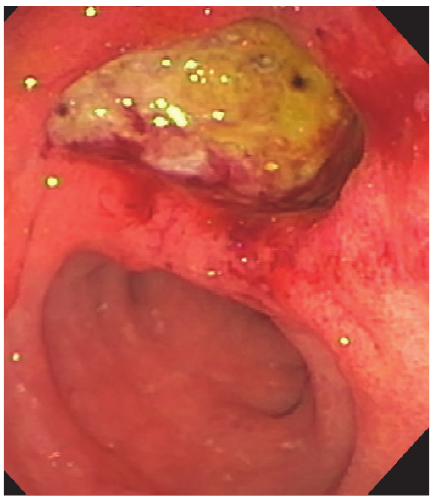
Figure 1: EGD showing 2 cm deeply cratered ulcer in the second portion of the duodenum, suspicious for ZES.